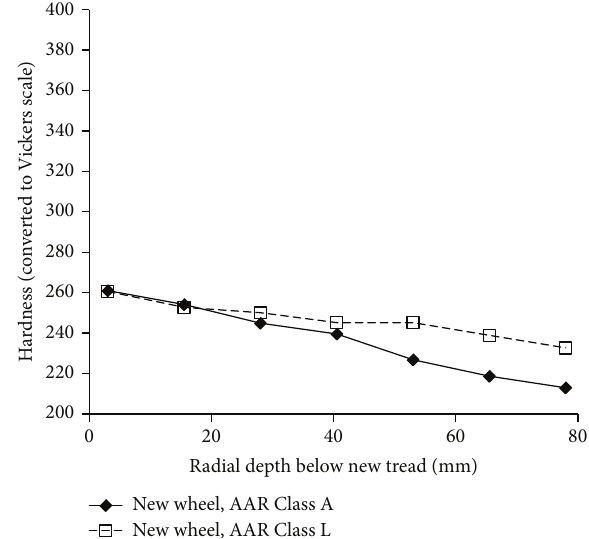
Figure 2: Trends of hardness with depth below the tread surface for new quenched wheels, adapted from Grundy